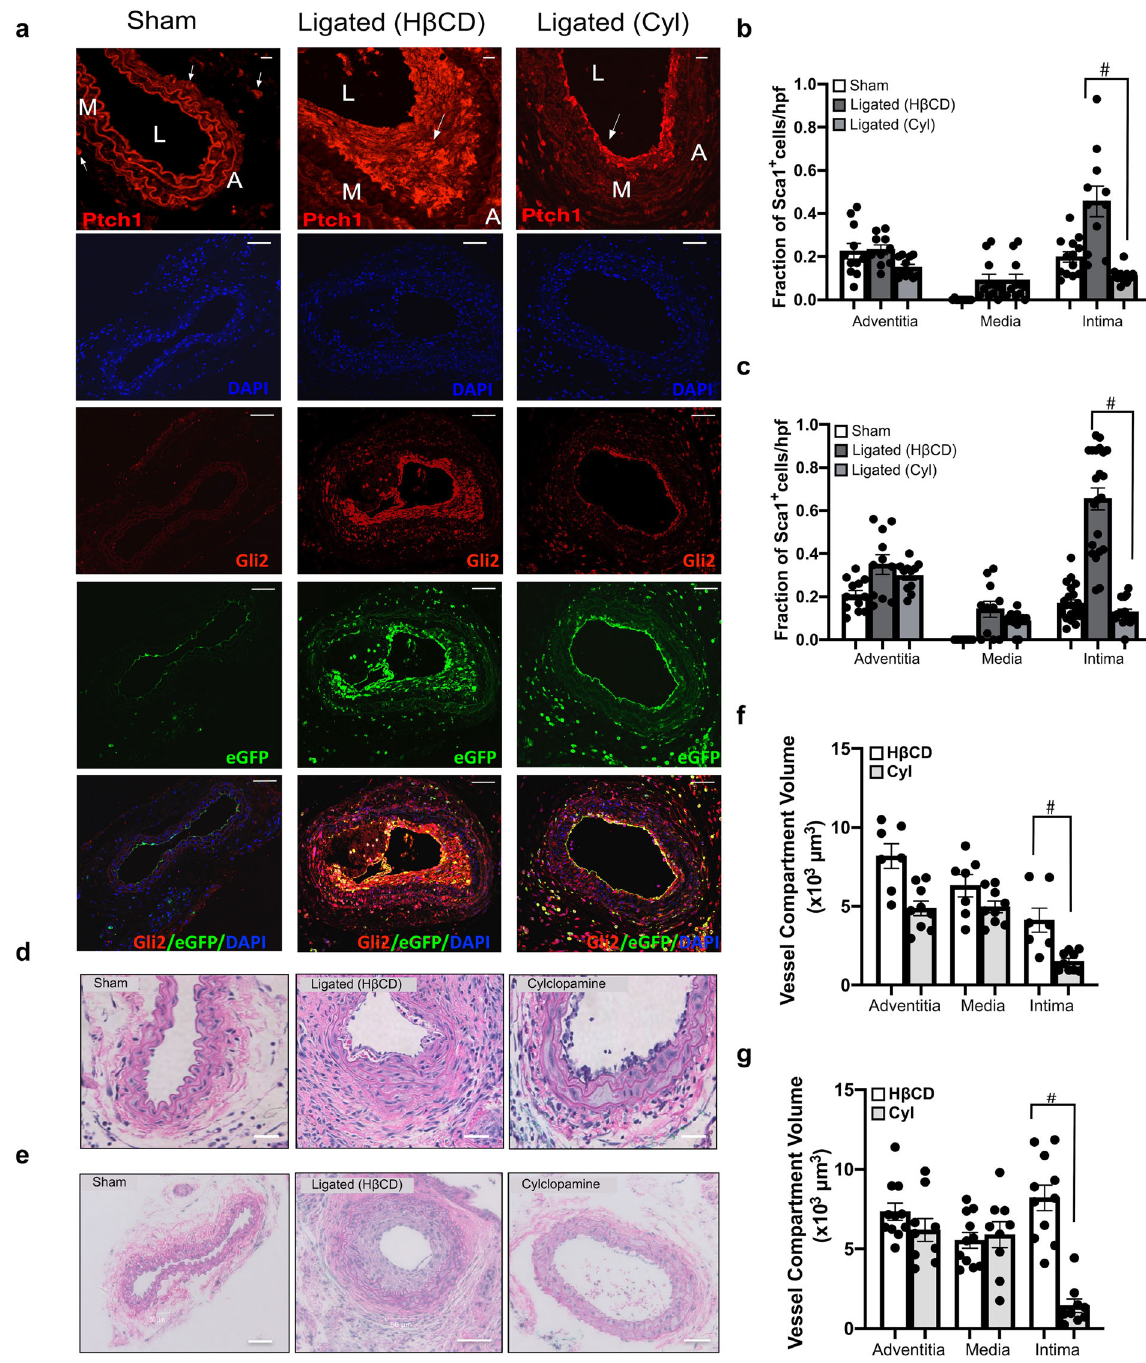
Fig. 4 Inhibition of Hh signalling attenuates intimal thickening and Sca1 cell expansion following iatrogenic fl ow restriction. a Representative immuno fl uorescence images of Hh receptor patched 1 (Ptch1) (red), Hh target gene Gli2 (red), Sca1-eGFP (green) expression and merged (eGFP/Gli2/DAPI) in carotid artery cross sections from sham-operated, ligated vehicle control (H β CD), and ligated + cyclopamine (10 mg/kg, IP) treated mice after 14 days. Scale bar = top panel: 50 µm, all other panels: 20 µm. b, c Cumulative data showing the fraction of Sca1-eGFP cells within the adventitia, media and intima from sham-operated, ligated vehicle control (H β CD), and ligated + cyclopamine (Cyl) Sca1-eGFP mice after b 7 days and c 14 days. Data are the mean ± SEM of fi ve sections per experimental group, # p ≤ 0.05 vs ligated H β CD controls and are representative of a minimum of four animals per experimental group. d, e Representative H&E staining of carotid artery cross sections from sham, ligated control (H β CD vehicle), and ligated + cyclopamine (Cyl) treated animals after 7 d ( d ) and e 14 d. Scale bar = 50 µm. f, g Morphometric analysis of vessel compartment volumes for ligated control (H β CD), and ligated + cyclopamine (Cyl) treated animals after f 7 d and g 14 d. Data mean ± SEM of 7 – 12 sections analysed from four animals, # p ≤ 0.05 vs ligated control (H β